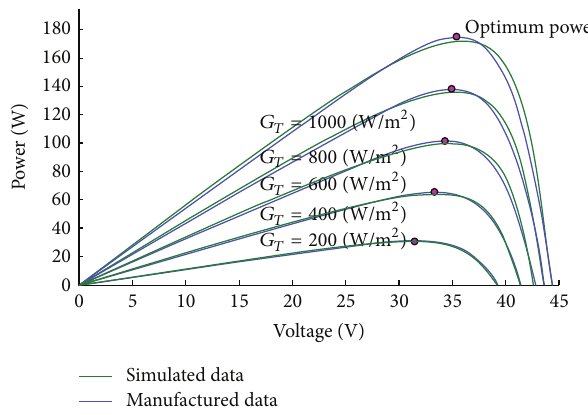
Figure 7: P-V characteristic curve at constant temperature of 25 ∘ C.